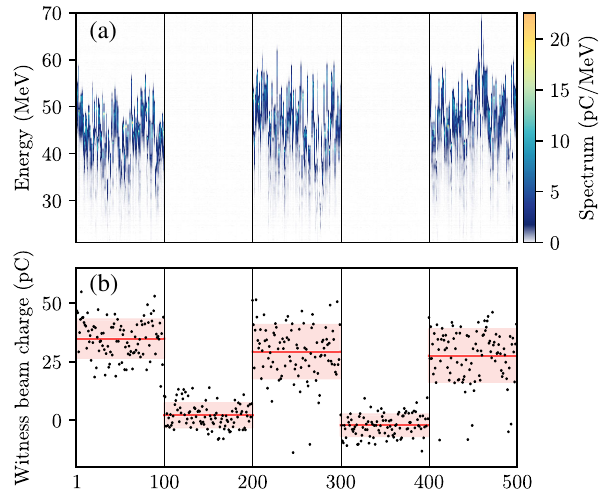
FIG. 2. (a) Energy spectra and (b) charge of the injected witness beam. The injection is switched off by blocking the injection laser for shot numbers 101 – 200 and 301 – 400. The mean value for each group of 100 shots is indicated by a solid line, while the rms variation of charge values is shown by a shaded